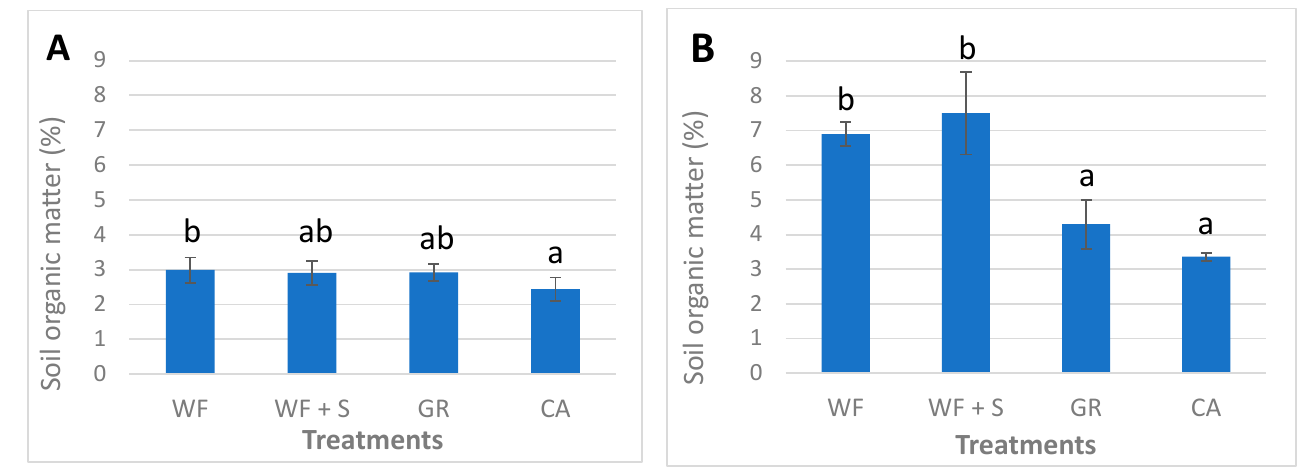
Figure 7. Soil organic matter values in 2018 ( A ) and in 2022 ( B ). Same letters above bars mean no statistical difference. (WF: weed control fabric; WF + S: weed control fabric and straw; GR: grass vegetation; CA: cultivated alfalfa; ˝Osag á rd,